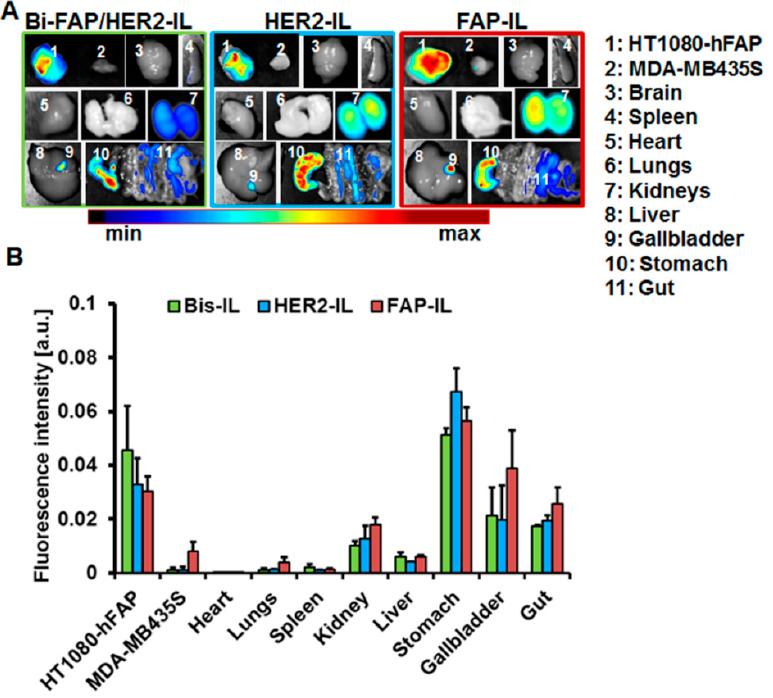
Figure 8. Biodistribution of HER2’ and FAP’scFv targeted liposomes in tumor bearing mice. ( A ) Representative NIR-fluorescence images of organs and tumors from mice bearing stable human FAP expressing fibrosarcoma HT1080-hFAP and endogenous FAP expressing human melanoma (MDA-MB435S) excised 48 h post intravenous injection of the indicated liposomes. ( B ) Semiquantitative analysis of fluorescence intensities of tumors at designated time points post probe injection. Each point represents the mean of fluorescence intensities of regions of interest (ROIs) placed on the respective tumors or organs. n = 5 mice ± SEM.